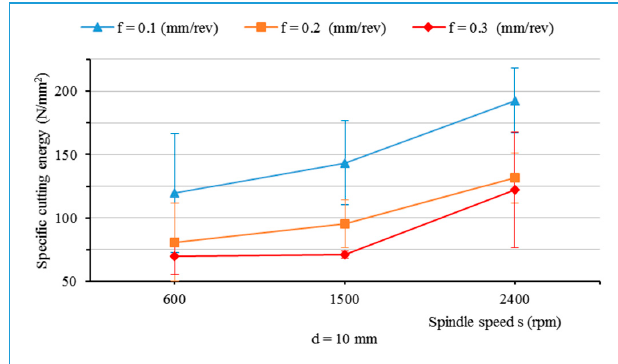
Figure 7. Specific cutting energy for thrust force as a function of spindle speed with different feed rates and drill bit diameter of 10 mm.